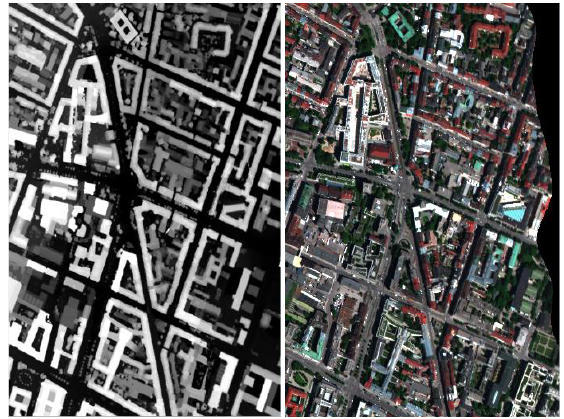
Figure 1. Left image: 3K DSM, Right image: